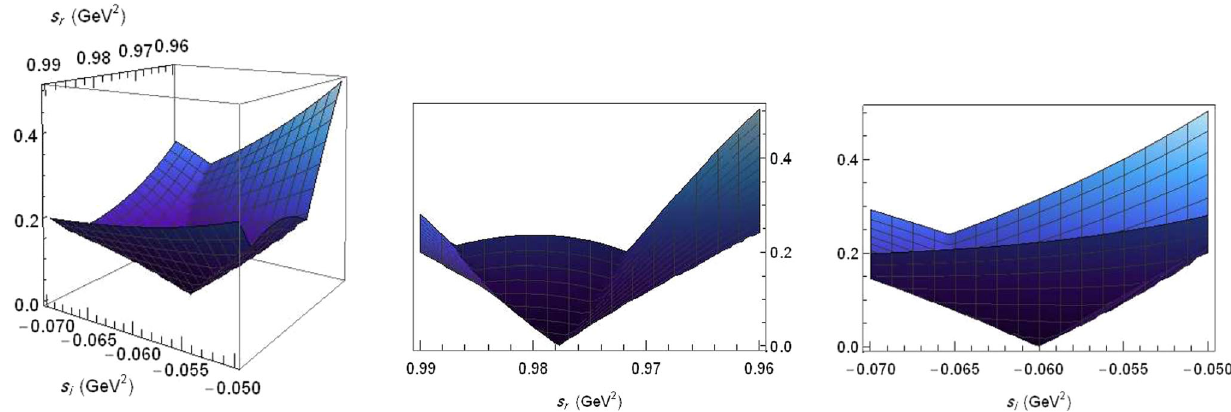
Fig. 14 3D plot of function F ( s r , s i ) [defined in (55)] over complex plane (left), together with its projections onto F − s r plane (middle) and F − s F touches down represents the first physical isovector scalar meson pole and provides the properties of the i plane (right). The point at which a 0 ( 980 )